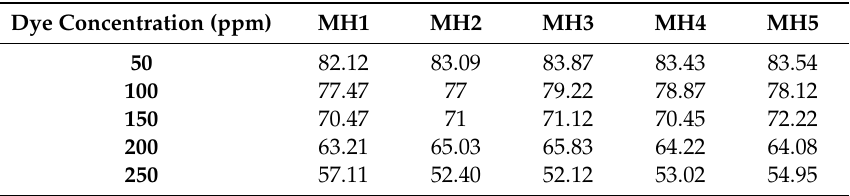
Figure 8. Photocatalytic degradation of alizarin red (AR) dye at di ff erent dye concentrations (50–250 ppm) by 0.025 g of MH3 and MH5 after 60 min of photocatalytic activity. Table 7. Photocatalytic degradation of di ff erent concentrations (50–250 ppm) of alizarin red (AR) dye by MH1–MH5 (0.025 g) after 60 min of photocatalytic